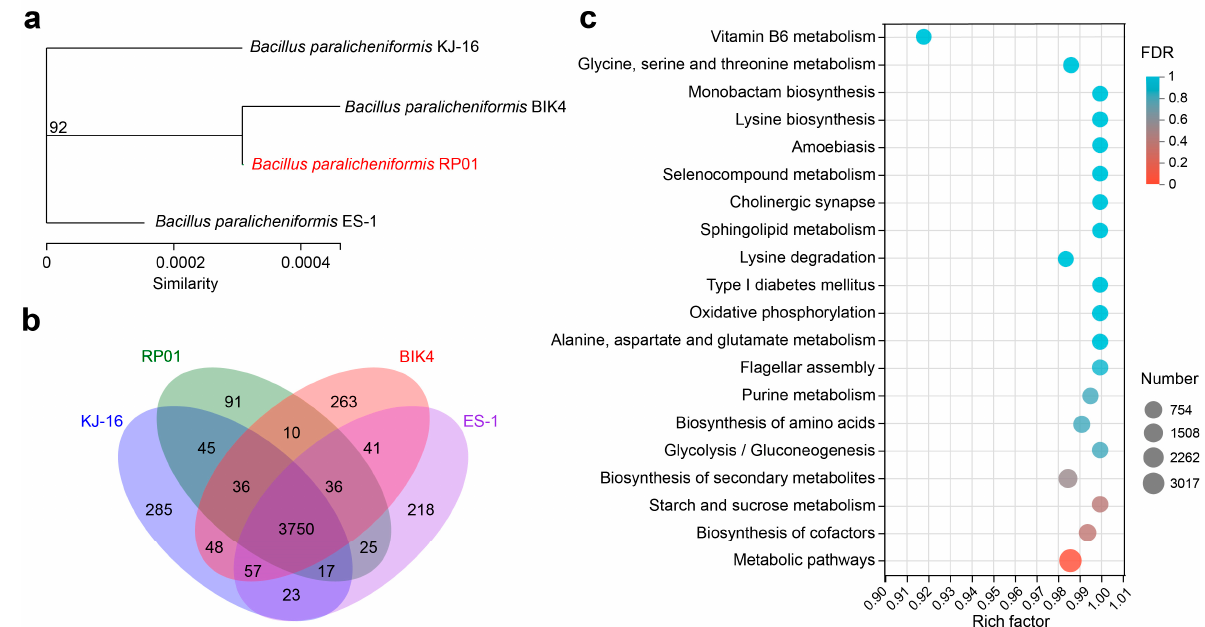
Figure 7. Comparative analysis of the B. paralicheniformis RP01 genome. ( a ) Molecular evolutionary tree for the four strains. The tree was built using housekeeping genes ( dnaG , frr , infC , nusA , pgk , pyrG , rplA , rplB , rplC , rplD , rplE , rplF , rplK , rplL , rplM , rplN , rplP , rplS , rplT , rpmA , rpoB , rpsB , rpsC , rpsE , rpsI , rpsJ , rpsK , rpsM , rpsS , smpB and tsf ) by maximum likelihood method with a bootstrap value of 1000. ( b ) Venn diagram shows the number of genes in all four strains. ( c ) KEGG enrich- ment analysis of homologous genes in four strains. The X-axis represents rich rate (refers to the ra- tio of the number of genes enriched in the pathway to the number of annotated genes; a larger ratio indicates greater enrichment). The size of the point indicates the number of genes in this pathway and the color of the point indicates the signi fi cance of enrichment.